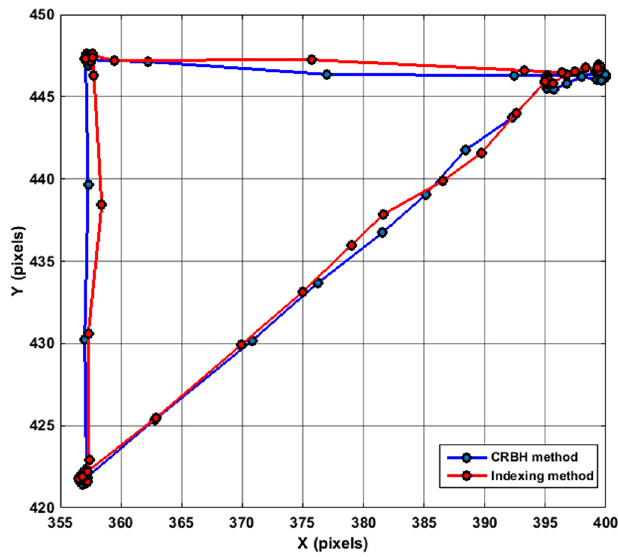
Figure 16. The performance of the two presented techniques in 2D tracking process.